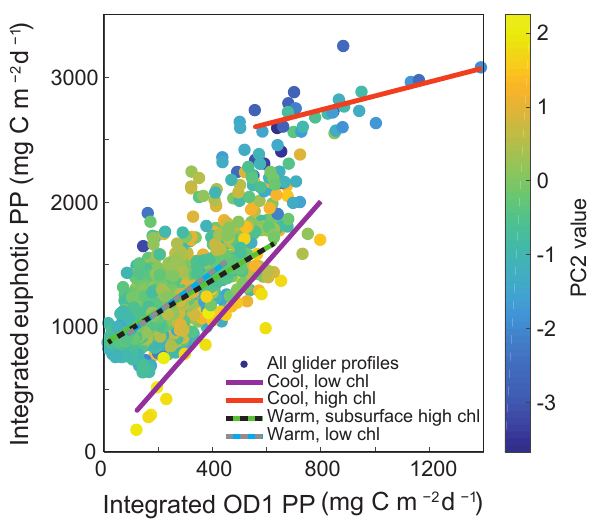
Figure 7. Integrated primary production (PP) within the first optical depth (OD1) versus integrated primary production over the euphotic zone. Each profile is colored by its PC2 value. The trend lines for all profiles falling within the four end-member profile clusters are